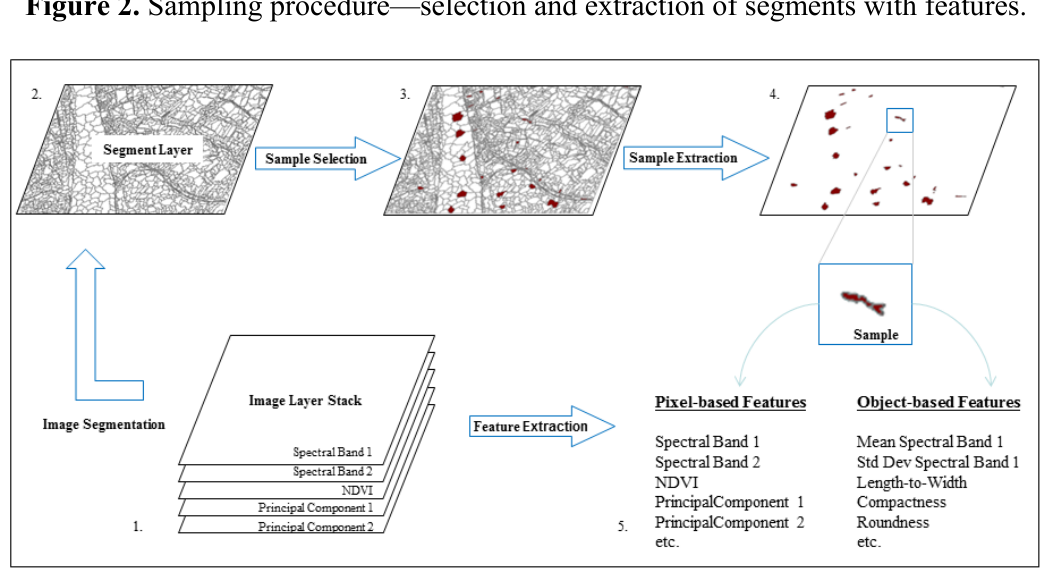
Figure 2. Sampling procedure—selection and extraction of segments with